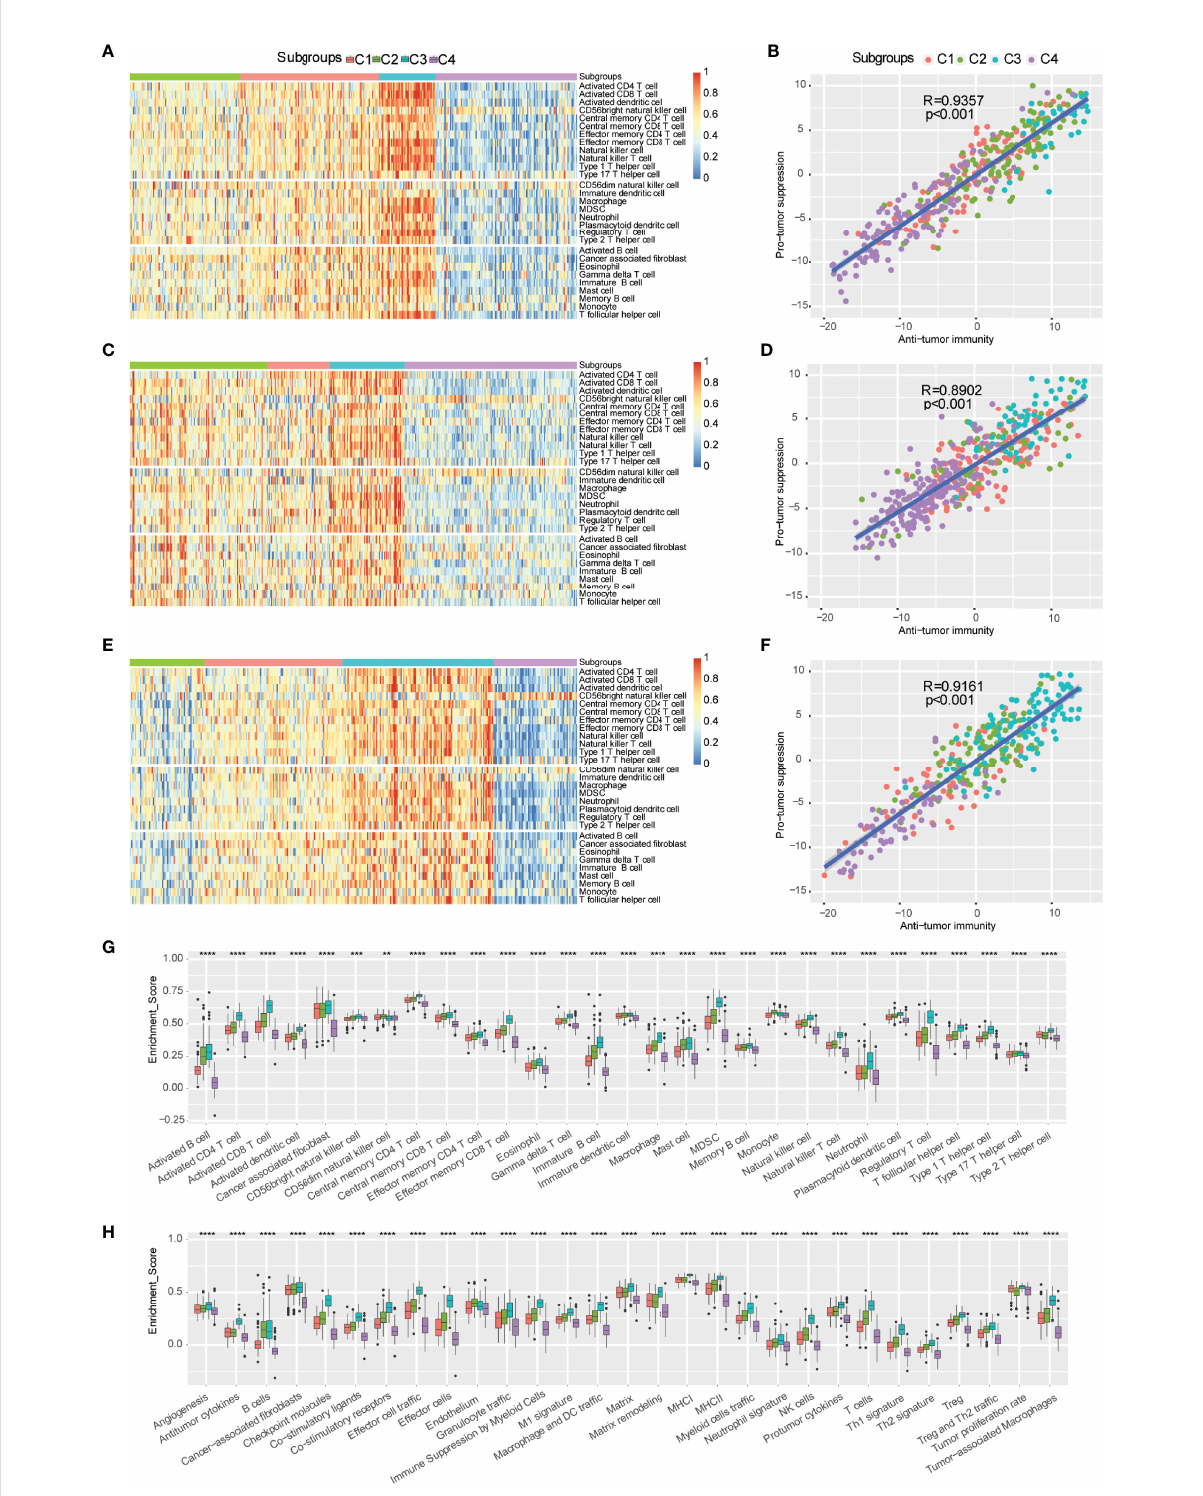
FIGURE 4 Distributions of tumor-in fi ltrating immune cells and molecular signatures of immune subtypes. (A-F) Heatmap and correlation analysis between immune subtypes and tumor-in fi ltrating cells in TCGA-BLCA (A, B) , E-MTAB-4321 (C, D) , and IMvigor210 (E, F) . (G) Distribution of 29 immune cells in distinct immune subtypes. (H) Scores of 29 molecular signatures in distinct immune subtypes. ns, **p<0.01; ***p<0.001; and